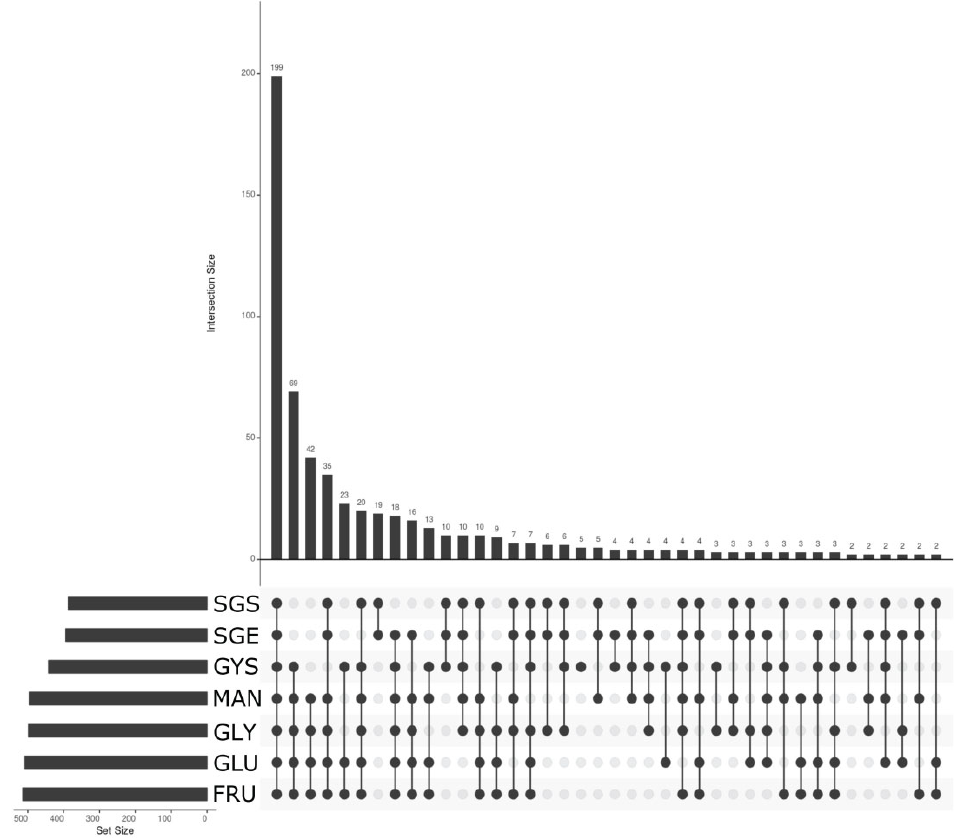
Figure 7. Relation of overexpressed genes between conditions for Pseudomonas sp., strain L5B5. The figure represents those genes within the 90% of overexpressed genes. SGS: Solid culture. NA-Glycerol. Stationary phase of bacterial growth; SGE: Solid culture. NA-Glycerol. Exponential phase of bacterial growth; GYS: Liquid culture. Nutrient broth with glycerol. Dead phase of growth; GLY: Liquid culture. NB-Glycerol. Stationary phase of growth; GLU: Liquid culture. NB-Glucose. Stationary phase of growth; MAN: Liquid culture. NB-Mannose. Stationary phase of growth; FRU: Liquid culture. NB-Fructose. Stationary phase of